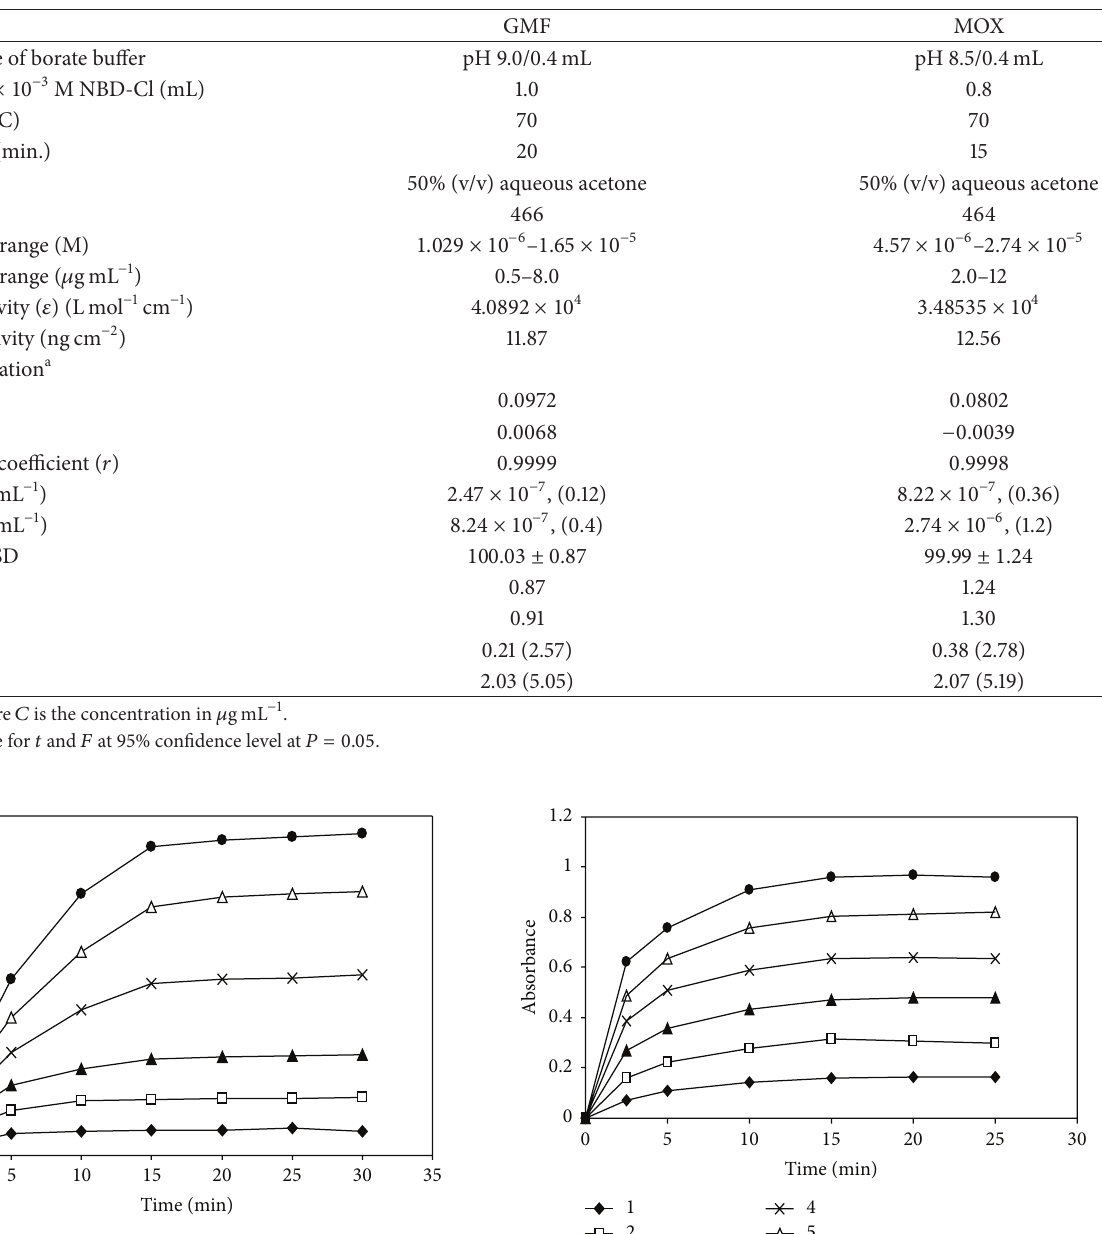
Table 3: Experimental and analytical parameters for the kinetic spectrophotometric determination of GMF and MOX.